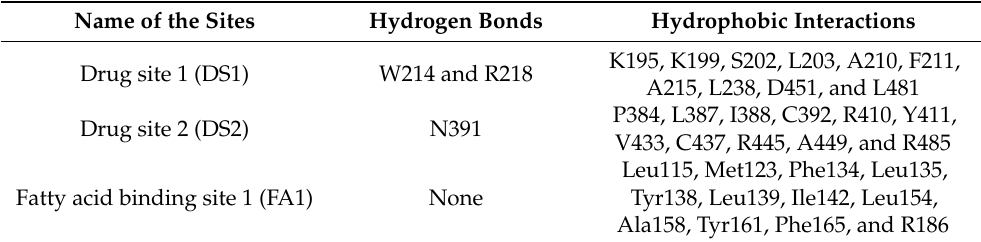
Table 6. Interacting residue analysis of three sites of HSA with